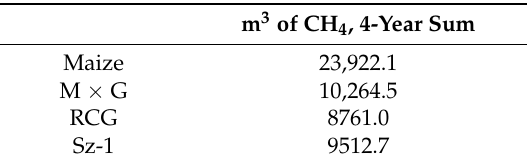
Table 16. CH 4 yield depending on phytomass yield (m 3 of CH 4 , Σ for 4 years).